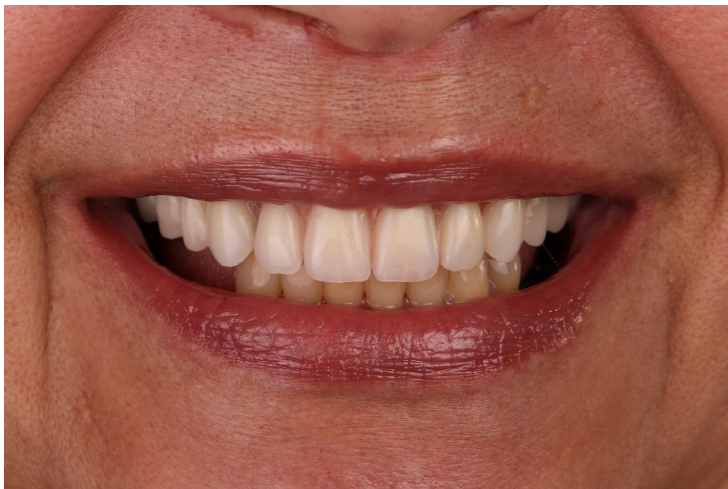
Figure 17. Post-operative orthopantomography of the maxillary rehabilitation through the All-on-4 concept using live navigation.